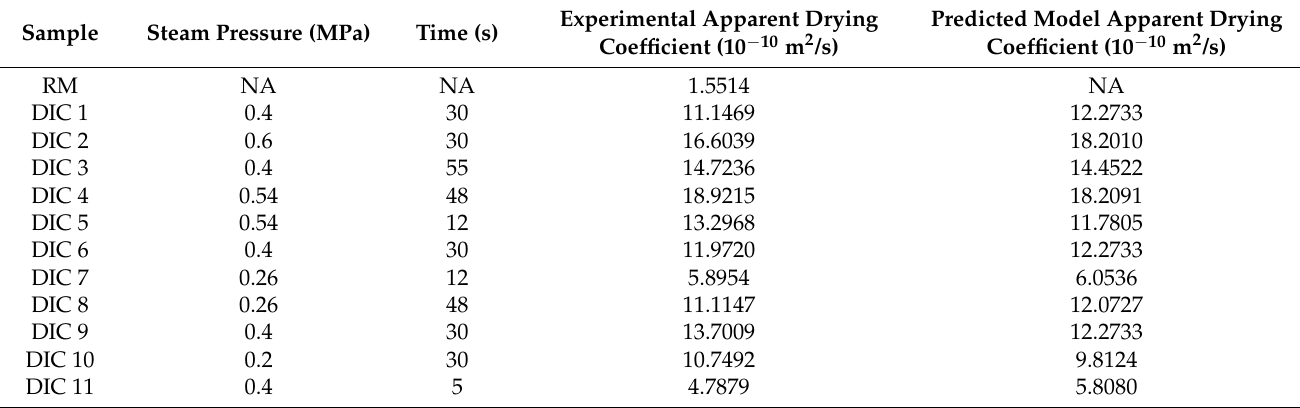
Table 3. Experimental data and predicted model results of the apparent drying coefficient of mangoes.